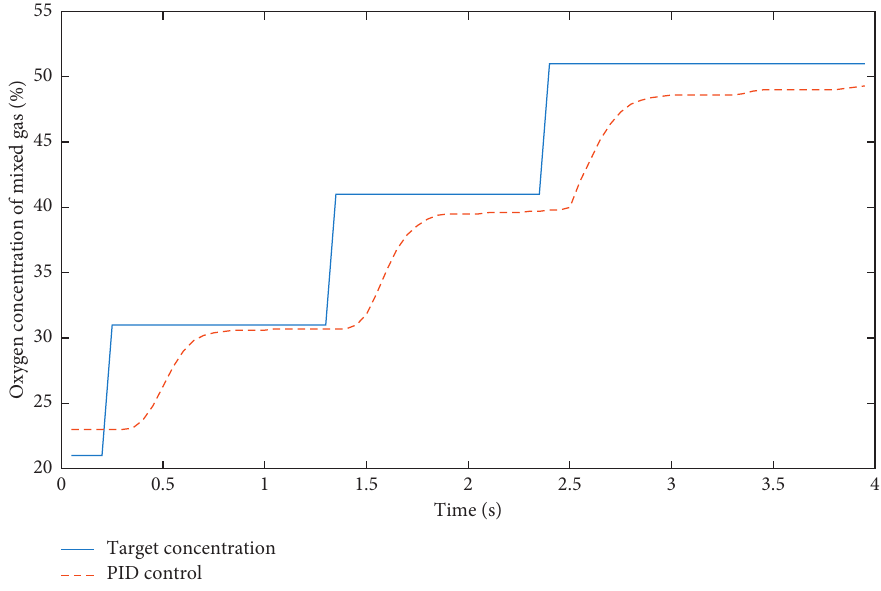
Figure 12: Comparison of mixed gas oxygen concentration under PID